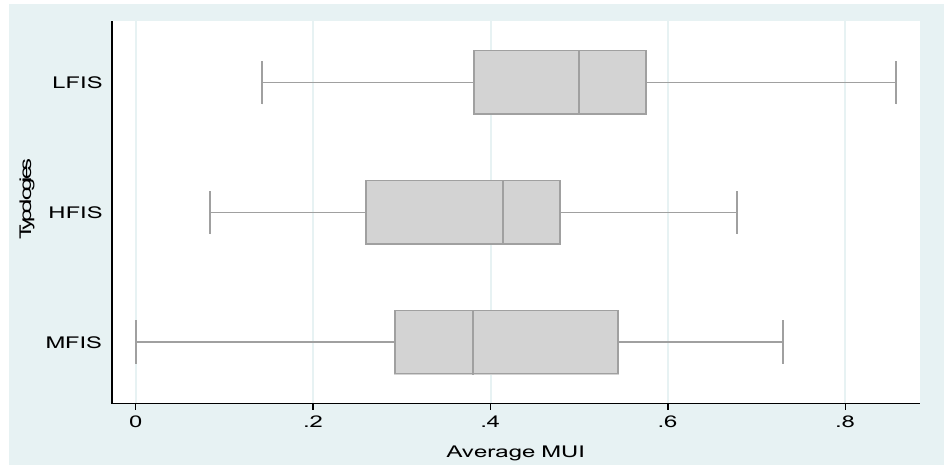
Figure 5. Average Score on the Management and Utilization Index by typology. Note: LFIS = Low Forest Income Share, HFIS = High Forest Income Share, and MFIS = Medium Forest Income Share.